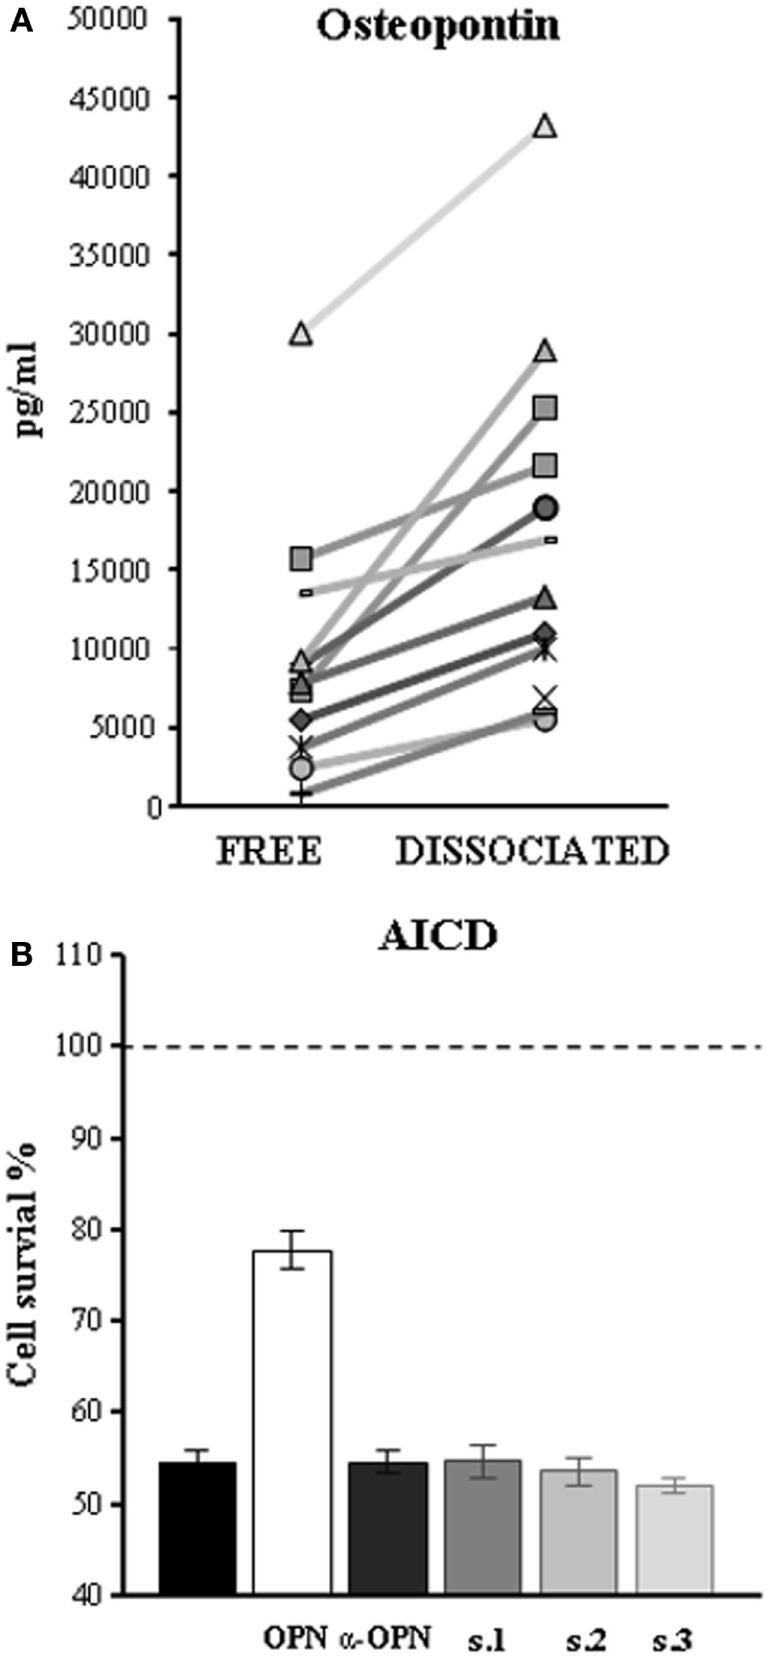
Autoantibodies (autoAbs) to osteopontin (OPN) in serum of multiple sclerosis (MS) patients form immune complexes and neutralize OPN activities. (A) Heat-mediated dissociation of immune complexes increases the amount of OPN in the sera of MS patients as detected by ELISA. Each symbol represents serum from a different patient. (B) AutoAbs to OPN reverse inhibition of activation-induced cell death (AICD) mediated by OPN, by neutralizing its effect. AICD was induced by treating phytohemagglutinin-activated PBMC cell cultures with anti-CD3 mAb (black histogram) and cell survival detected 18 h later; results are expressed as relative cell survival % by setting 100% on the cultures performed in the absence of the anti-CD3 mAb and their means (dashed line). Histograms represent AICD in the presence of recombinant OPN (white), a commercial-neutralizing antibody to OPN (dark gray), or serum of three high-expressor patients (s1, s2, and s3).